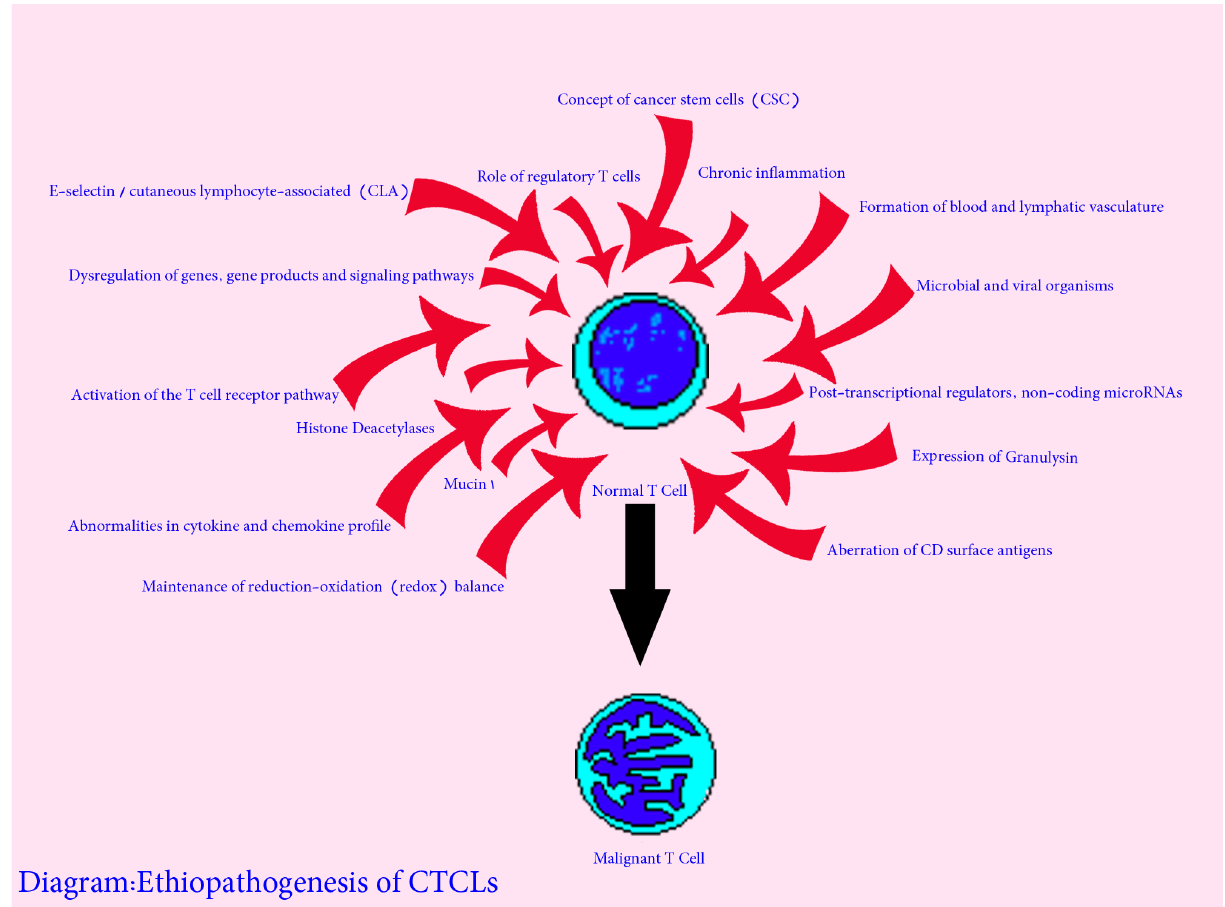
Figure 3. Etiopathogenesis of cutaneous T cell lymphoma. CTCL, cutaneous T cell lymphoma.